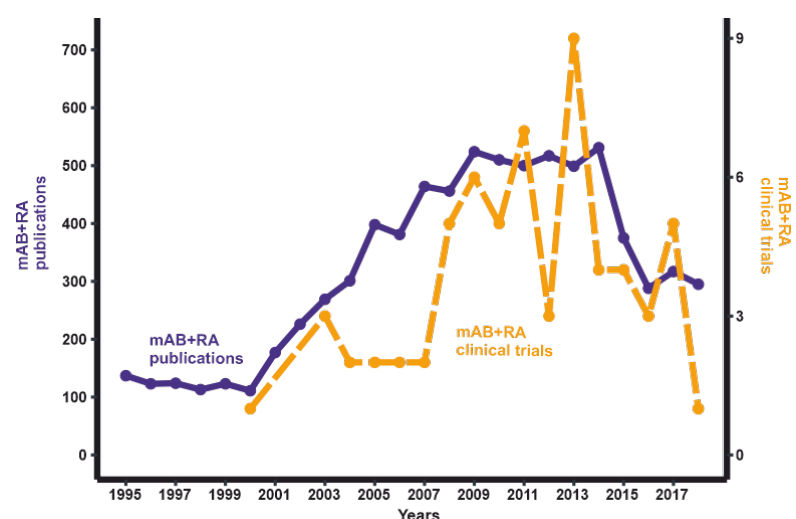
Figure 1. The dynamics of the publications / clinical trials number with keywords “monoclonal antibody” AND “rheumatoid arthritis” as of October 2019.